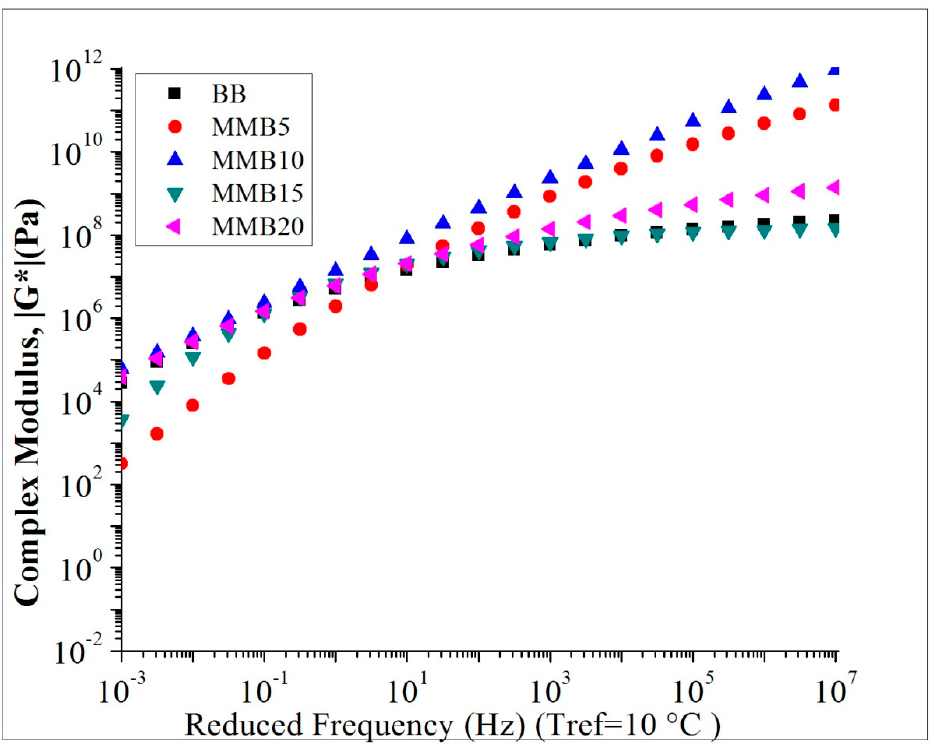
Figure 9. Lower temperature complex modulus master curve (T ref = 10 ◦ C).